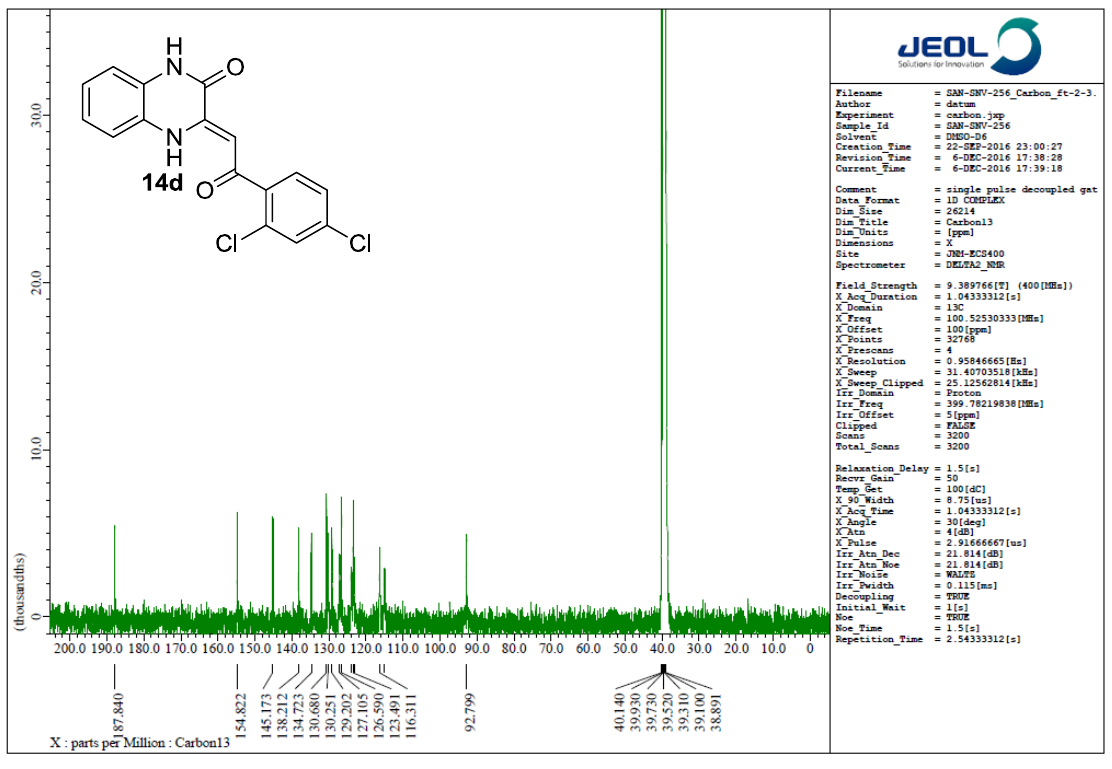
Figure 36 . 13 C NMR Spectra of Compound 14d